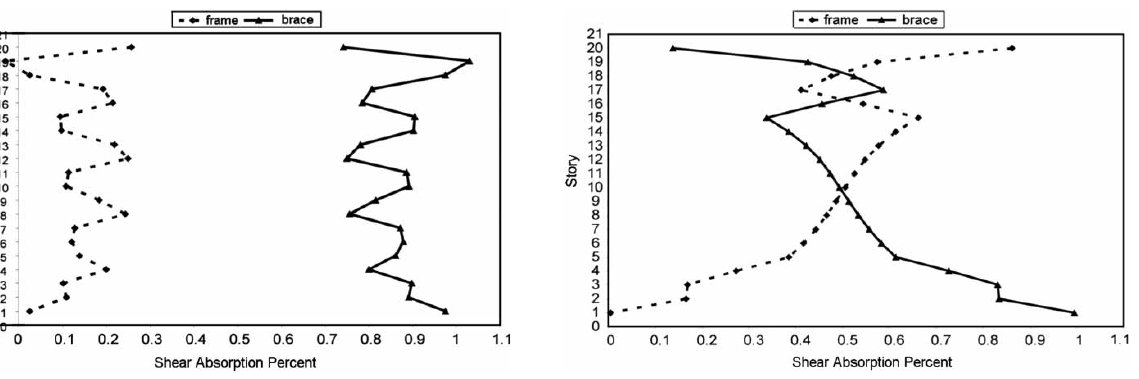
Fig. 17. Shear absorption percent of frame and brace systems in LSB20